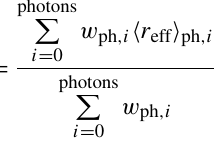
Figure 5. True-color image of a scene selected with the observation kernel method shown in Fig.